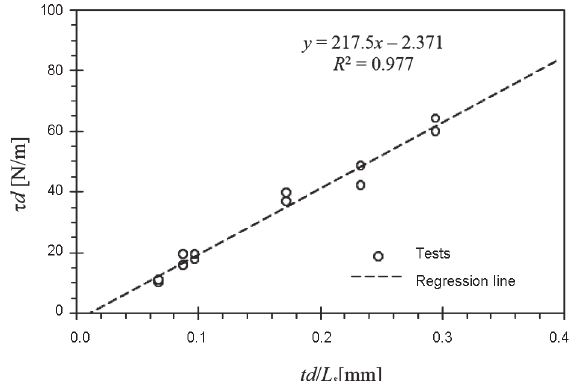
Fig. 8. τd versus td/L s for the tests of slab specimens using 51 mm deck with 0.9, 1.2, and 1.5 mm sheeting